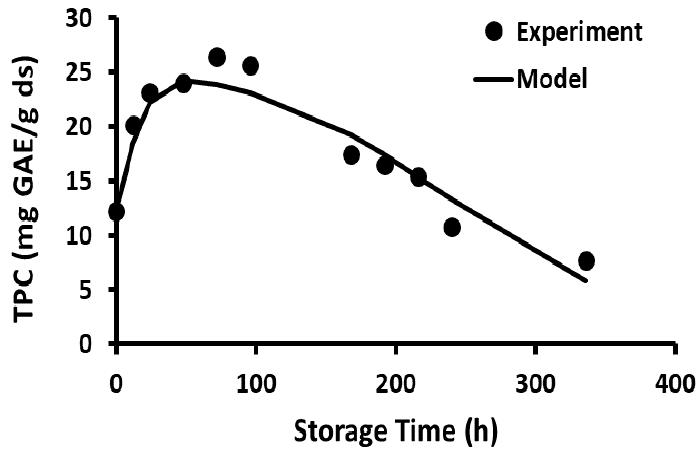
Figure 5. Polyphenol content during storage at 70 °C for 14 days.